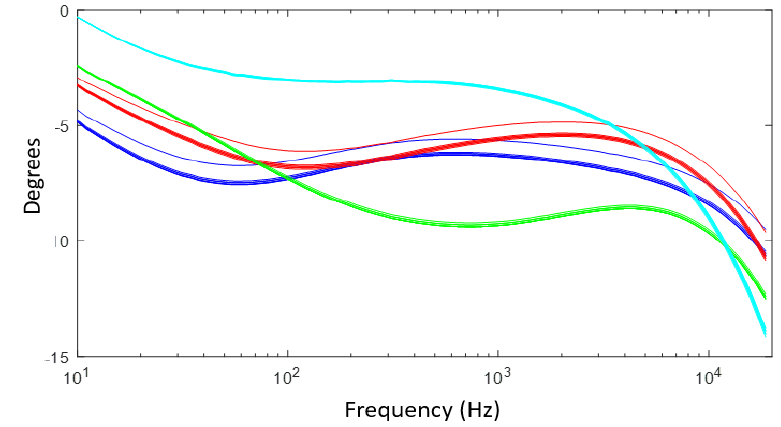
Figure 9. Magnitude results of the frequency response of the sensor of four soil samples and their sub-samples.